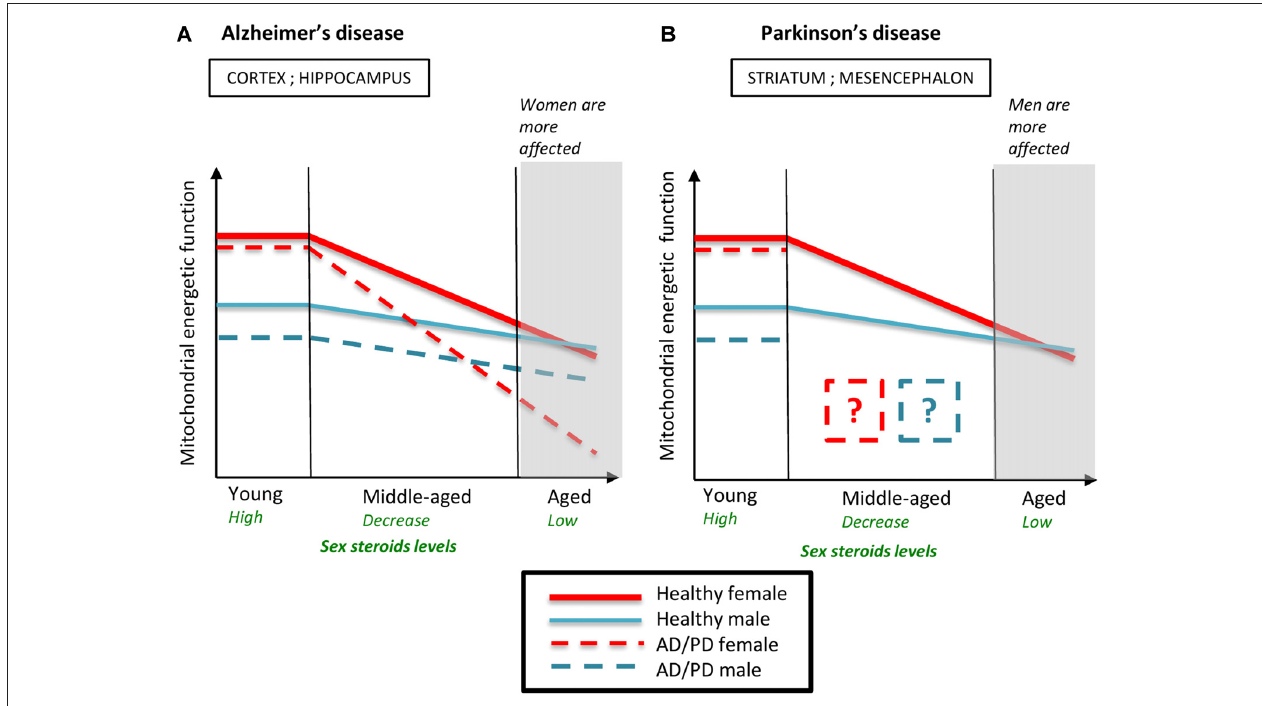
FIGURE 6 | Schematic representation of the evolution of mitochondrial energetic function in males and females during normal and pathological aging. Young healthy females have higher mitochondrial energetic function than young healthy males. The decline of ovarian steroids during reproductive senescence accentuates the age-induced mitochondrial decline. Mitochondrial energetic function is similar between aged males and females. (A) In Alzheimer’s disease (AD) models, young females are more protected against AD-induced mitochondrial failure than young males but the drop of ovarian steroids levels during reproductive senescence strongly precipitates mitochondrial impairment. Therefore, mitochondrial function is more altered in AD aged females than in AD aged males, which is consistent with the sex ratio observed in AD. (B) In Parkinson’s disease (PD) models, young females are also more protected than young males. Data on mitochondrial function in middle-aged and aged PD animals are lacking. AD, Alzheimer’s disease; PD, Parkinson’s disease. Data from Kenchappa et al. (2004), Yao et al. (2009, 2010), Misiak et al. (2010), Sundar Boyalla et al. (2011), Coskun et al. (2012) and Gaignard et al.